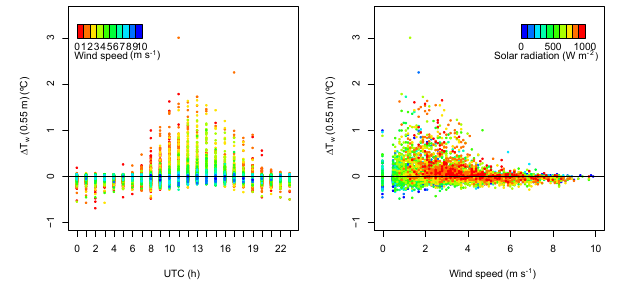
Figure 6. Warm layer effect ( (cid:49)T w ) at 0.55m at the reservoir of Bimont as a function of the time of measurement, wind speed and solar radiation, 21 February 2014 to 31 July 2016.